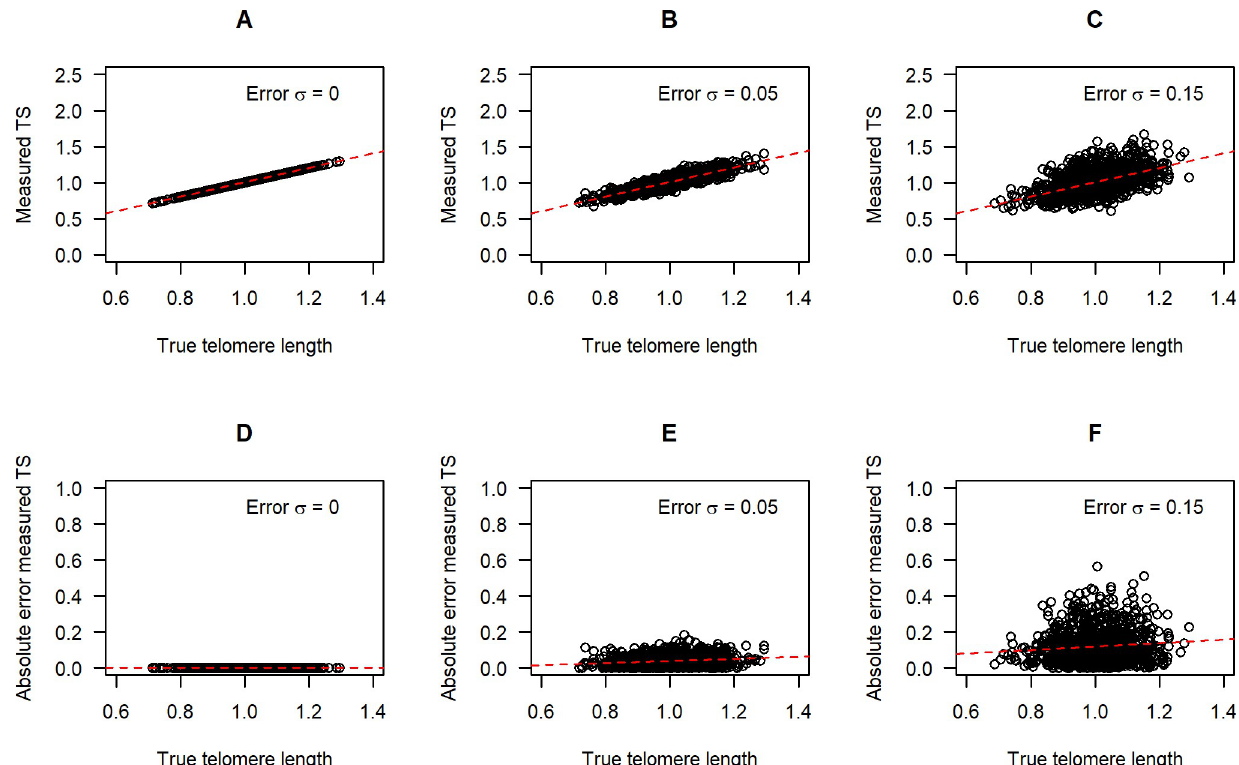
Fig 3. Association between measured TS ratio and true telomere length as measurement error increases. Top row: scatterplots of mTS against tl for σ ε = σ ε t = 0.00 (A); σ ε s = σ ε t = 0.05 (B); and σ ε s = σ ε t = 0.15 (C). Bottom row: The absolute magnitude of the difference between mTS and iTS , for σ ε s = σ ε t = 0.00 (D); σ ε s = σ ε t = 0.05 (E); and σ ε s = σ ε t = 0.15 (F). Red dotted lines indicate linear regressions of mTS on tl .